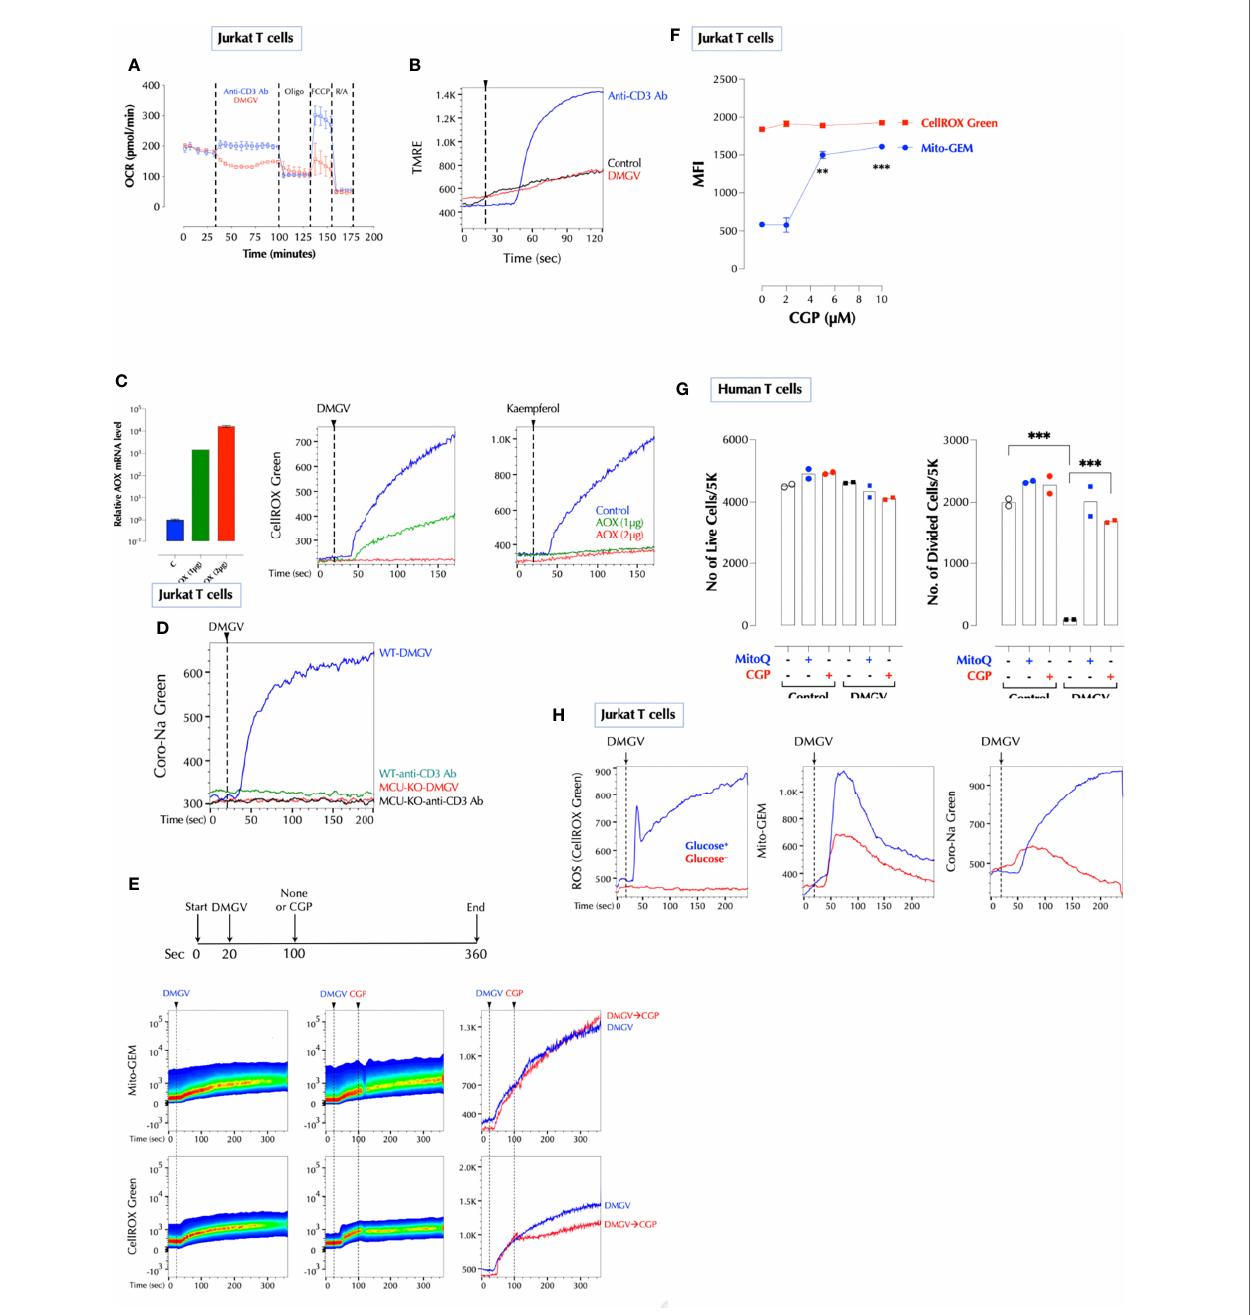
FIGURE 5 | Na + import to the mitochondria via NCLX is necessary for DMGV to induce ROS. (A) DMGV inhibits OxPhos in Jurkat cells. Seahorse assay was performed with DMGV (5µM) or anti-human CD3 Ab (5µg/ml) according to the manufacturer ’ s instruction. (B) DMGV does not increase the mitochondrial membrane potential. Jurkat cells loaded with TMRE were treated with none (control), DMGV (5µM) or anti-human CD3 Ab (5µg/ml). (C) Ectopic expression of alternative oxidase (AOX) inhibits ROS induction by DMGV. Jurkat cells were transfected with AOX, and ROS induction by DMGV (5µM) or kaempferol (5µM) was measured next day. (D) DMGV, but not TCR stimulation, induces Na + in fl ux to the mitochondria in an MCU-dependent manner. WT and MCU-KO Jurkat cells were loaded with Coro-Na Green and Na + in fl ux was measured by fl ow cytometry. (E) Induction of ROS, but not mitochondrial calcium in fl ux, by DMGV is inhibited by the NCLX inhibitor CGP37157 (CGP, 10µM). Jurkat cells treated with DMGV (5µM) for 60 seconds followed by CGP (or none). (F) CGP37157 increases the mitochondrial calcium level without inducing ROS. Jurkat cells were incubated with the indicated amount of CGP37157 for 30min and Mito-GEM and CellROX Green were measured by fl ow cytometry (n = 2). (G) CGP prevents DMGV-induced inhibition of T cell proliferation. Primary human T cells were stimulated as indicated (5µM DMGV, 1µM CGP, 100nM MitoQ) and the number of live and divided cells were measured after 3 days by fl ow cytometry. (H) DMGV do not induce ROS in a glucose-free medium. Jurkat T cells incubated overnight in a glucose+ or glucose- RPMI, and mitochondrial ROS, calcium in fl ux, and sodium in fl ux were measured the next day as above. **<0.01;